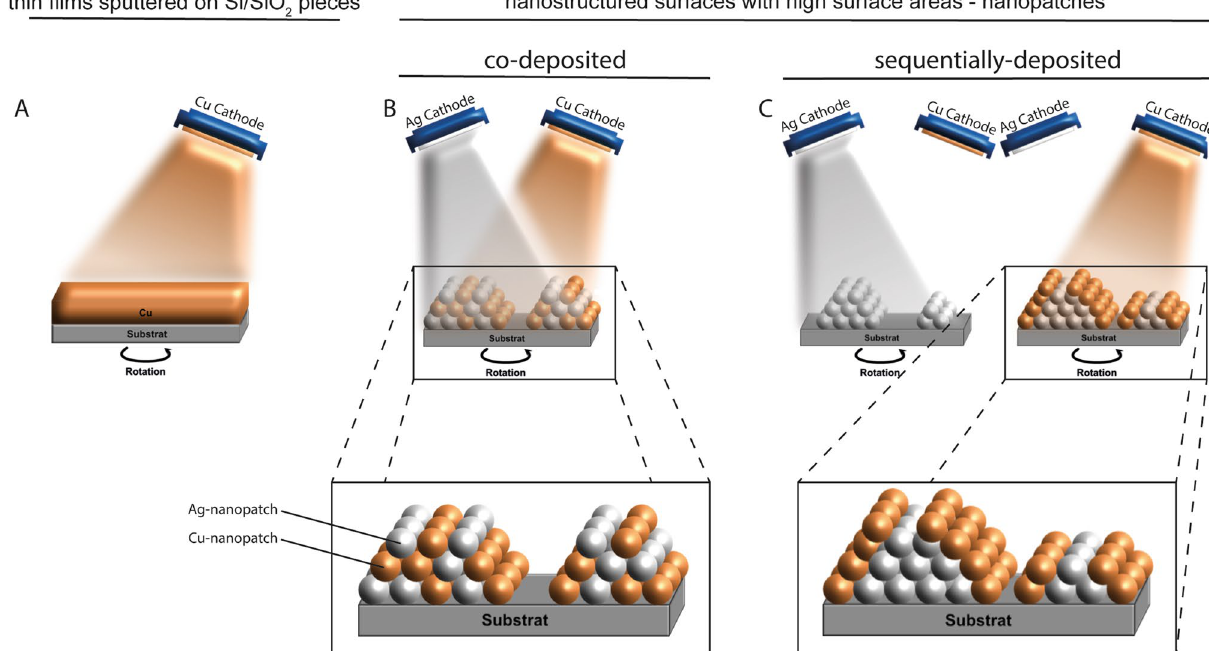
Figure 1. Schematic illustration (not to scale) of the fabrication of Cu and Ag thin film nanostructures by sputter deposition. ( A ) Elemental Cu sputtered homogeneously as a dense and continuous film with 50 nm thickness; ( B ) Cu- and Ag-nanopatches co-sputtered for 120 s; ( C ) Cu- and Ag-nanopatches sputtered sequentially for each 120 s. Nanopatches are island-like nanostructures with nominal thickness < 5